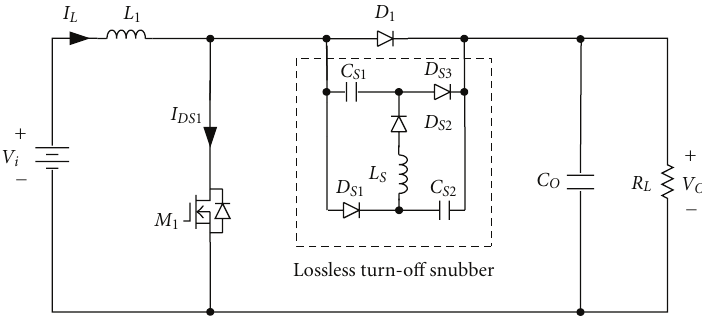
Figure 2: Topology of basic boost converter with a passive lossless turn-o ff